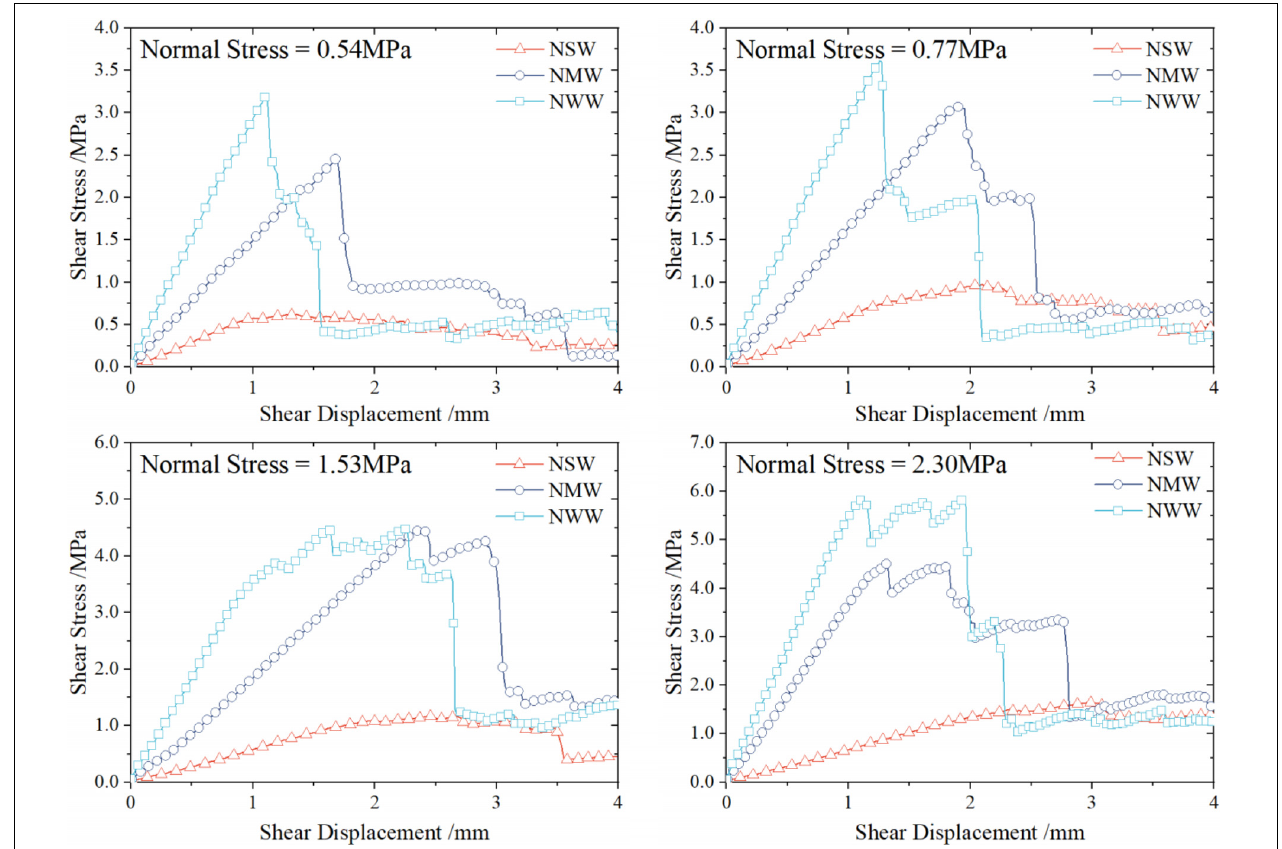
FIGURE 8 | Shear stress–displacement curves of numerical models under direct shear